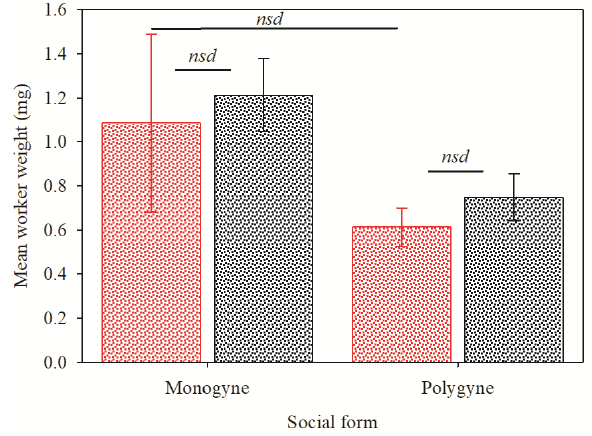
Figure 3. Mean (± standard error) worker weight of monogyne and polygyne worker ants that produced a positive and false negative InvictDetect TM Immunostrip ® response. Red bar on the left represents the false negative response, and black bar on right represents the positive response. NSD = no significant di ff erence by Student’s t -test for monogyne false negative versus positive response (t = − 0.34; df = 41; p = 0.74); polygyne false negative versus positive response (t = − 0.98; df = 41; p = 0.34); and false negative response between monogyne and polygyne ants (t = 1.15; df = 20; p =